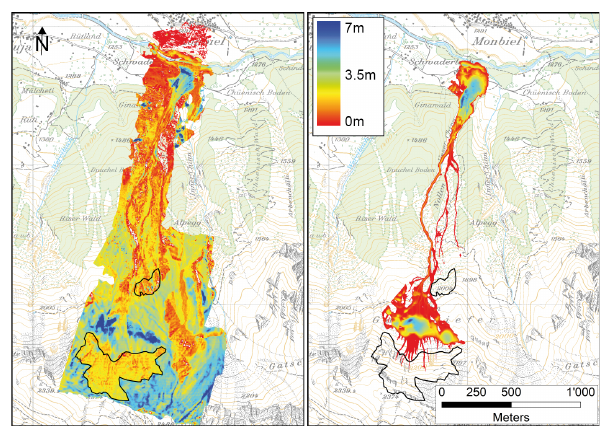
Fig. 15. Comparison between the measured snow depth, h s (left) and the deposit depths, h d , obtained from simulation ] 1 (right). The simulation reproduces the approximative location and volume of deposits ] 1 and ] 2, but it fails to reproduce the correct correlation between the slope angle and deposition depth (Fig.